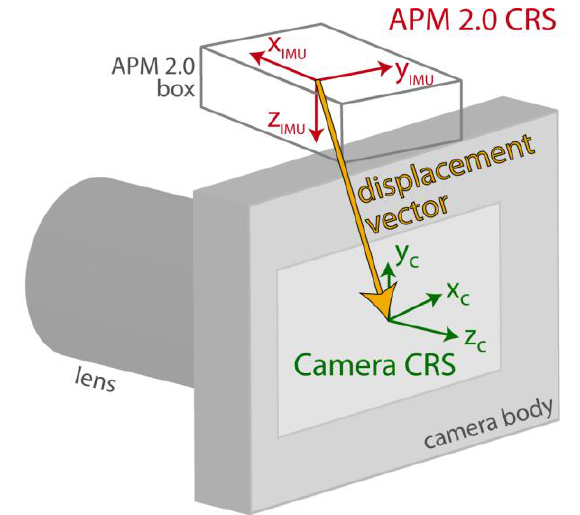
Figure 3. Misalignment between the digital still camera CRS (x c , y c , z c ) and the CRS of the APM 2.0 (x IMU , y IMU , z IMU